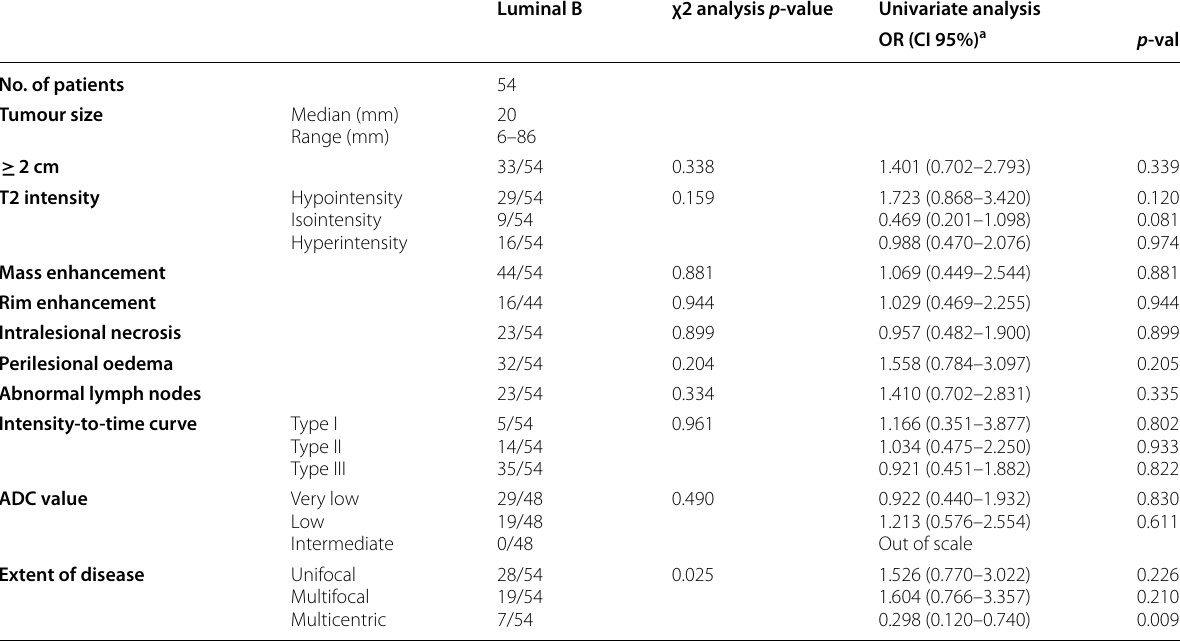
a OR Odds ratio, CI Confidence interval, ADC Apparent diffusion coefficient